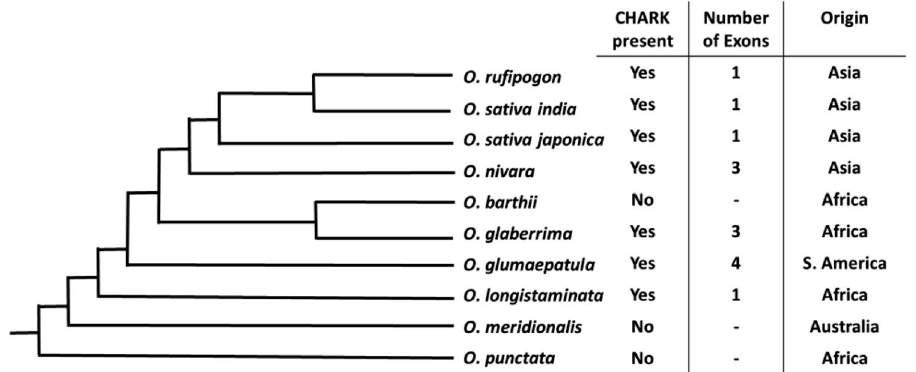
Figure 2. Phylogeny of CHARK in different rice species. The homologues for CHARK were searched for in ten rice species using the Gramene database 35 . The exon/intron structure was determined and the continent of origin of the species was identified. These findings were visualized by plotting them on a phylogeny of the different rice species which was published previously 38 .